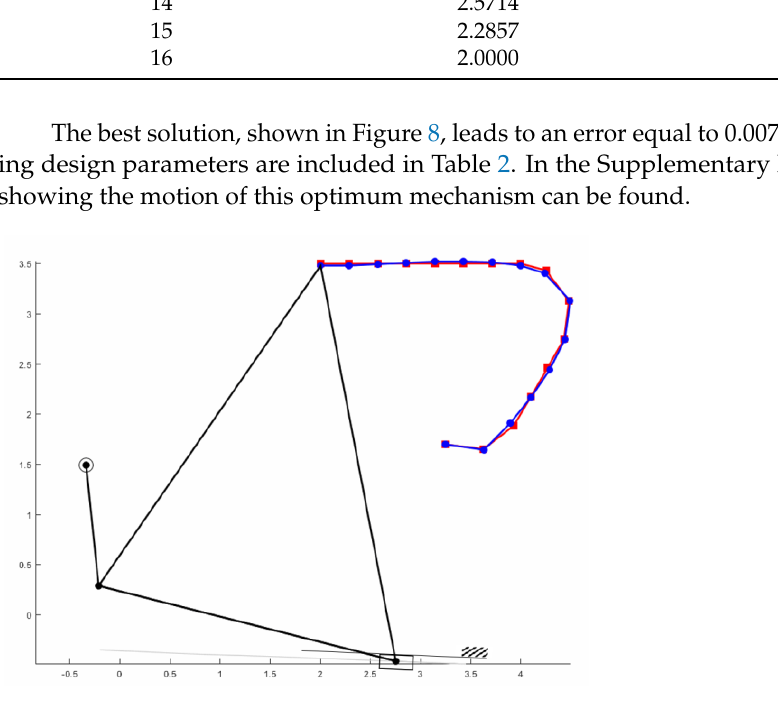
Figure 8. Example 1: best multi-start solution for slider-crank, E = 0.0073. Table 2. Example 1: optimum design parameters and inputs.